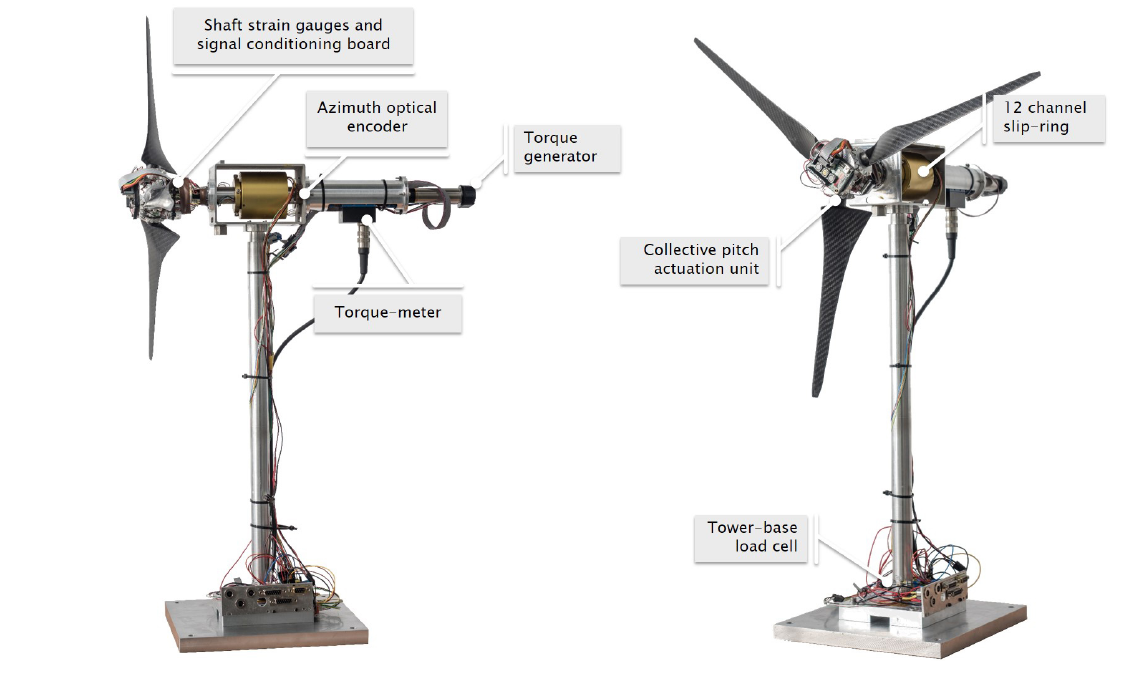
Figure 1. The G06 turbine with its main